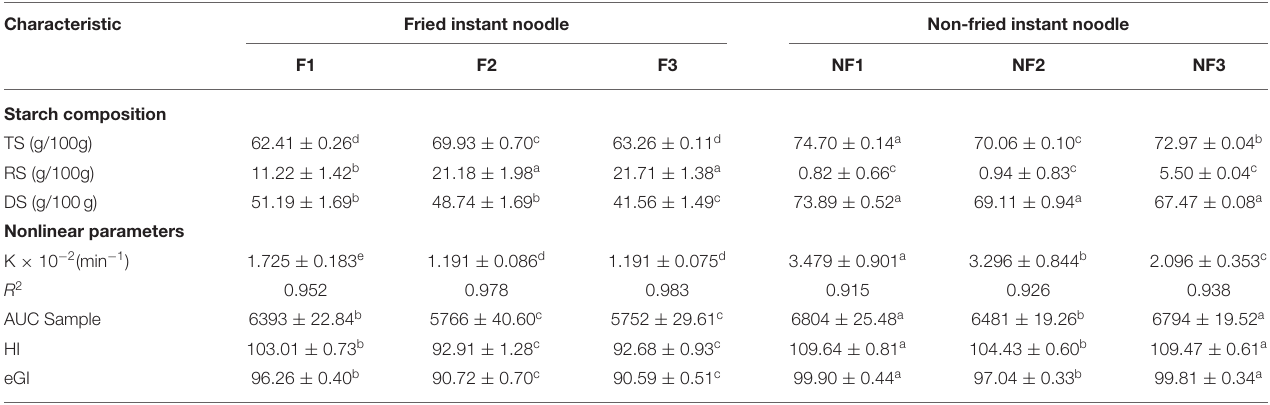
TABLE 4 | In vitro starch digestion and estimated glycemic index of fried and non-fried instant noodle.